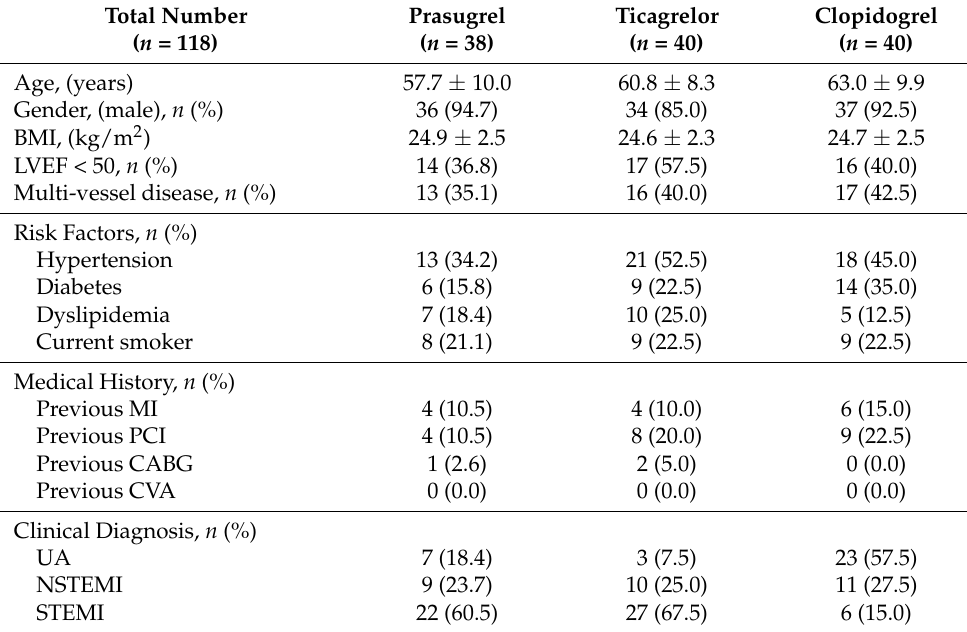
Table 1. The baseline characteristics of the study